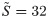
Comparison of approximate solution (for S˜=32, t = 1, Δt = 0.01 and j˜=0.21) and exact solution for Test Problem 2.